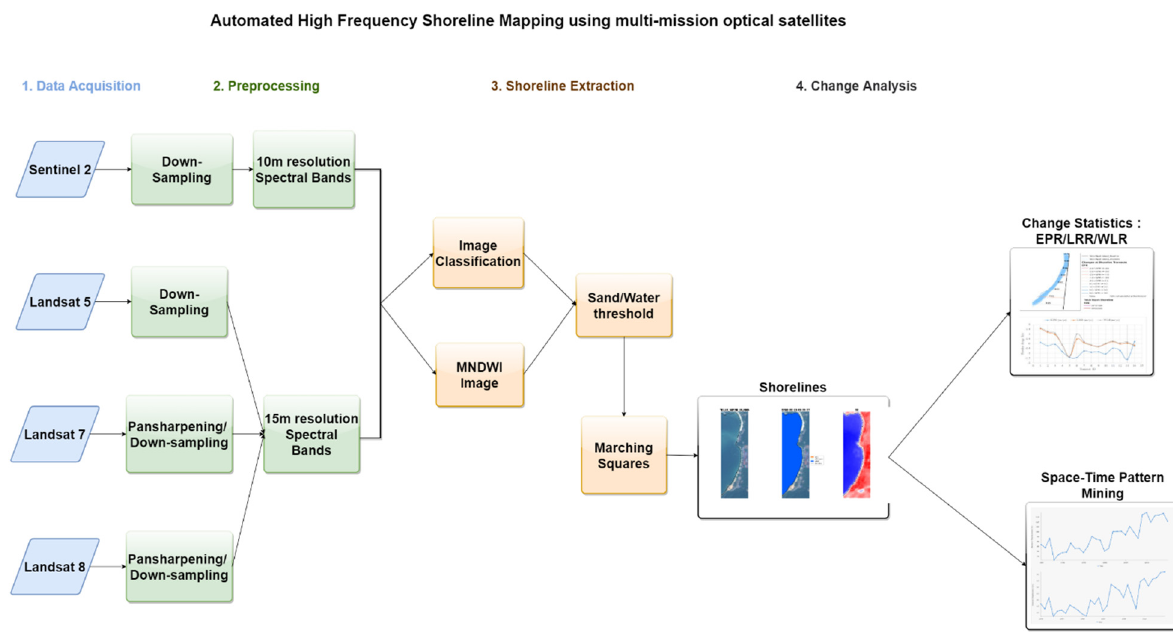
Figure 2. Workflow of the study’s methodology.